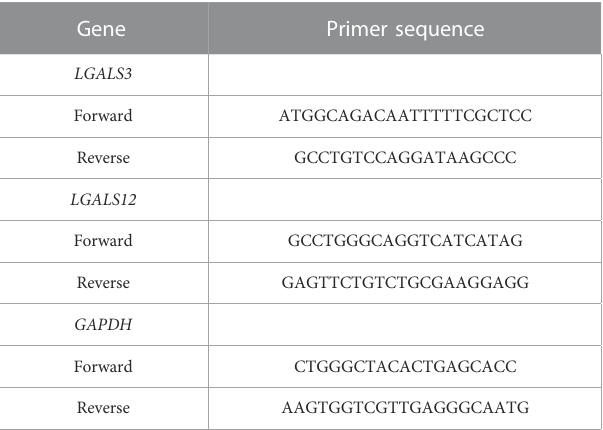
TABLE 1 The sequences of the forward and reverse primers for LGALS 3, 12, &